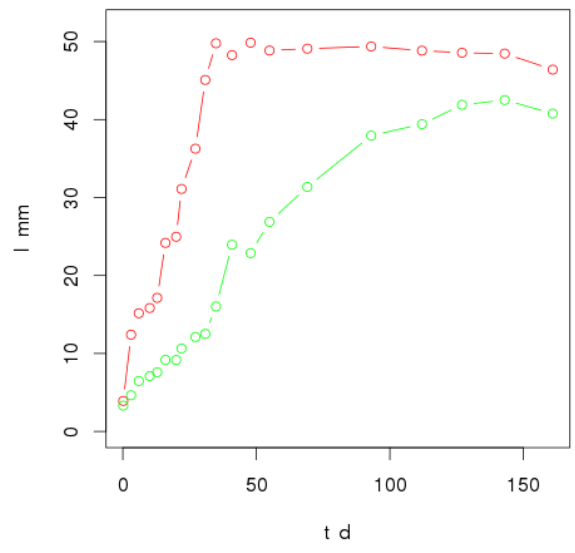
Figure 11. Lengths of the major axes of the FWHM vs. frame time (red: fast axis, green: slow axis) of the 22 Na experiment.